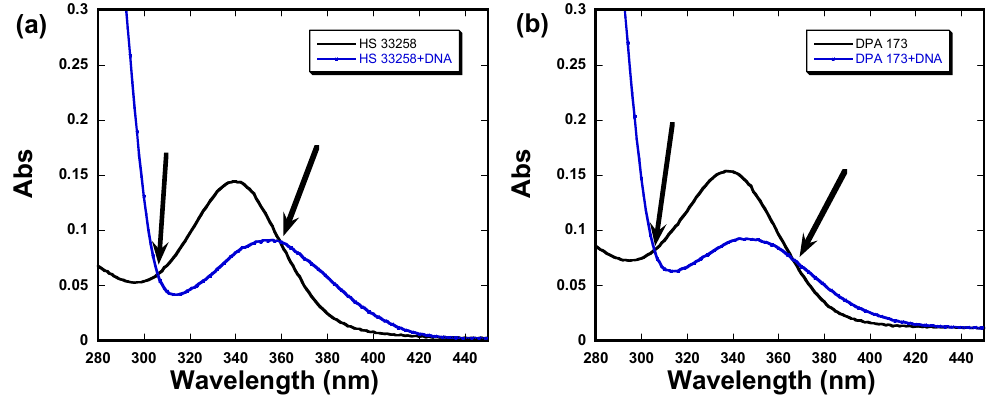
Figure 5. UV-Vis absorption spectra of ( a ) Hoechst 33258 and ( b ) DPA 173 in the presence of C- myc quadruplex. Arrows indicated isobestic